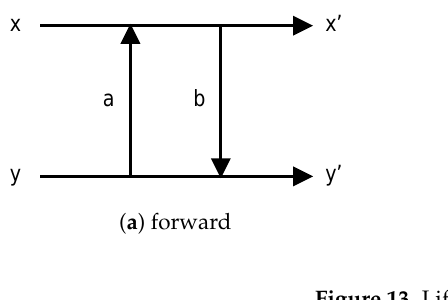
Figure 12. Implementations of JPEG XR POT rotation operators in Microsoft DPK.